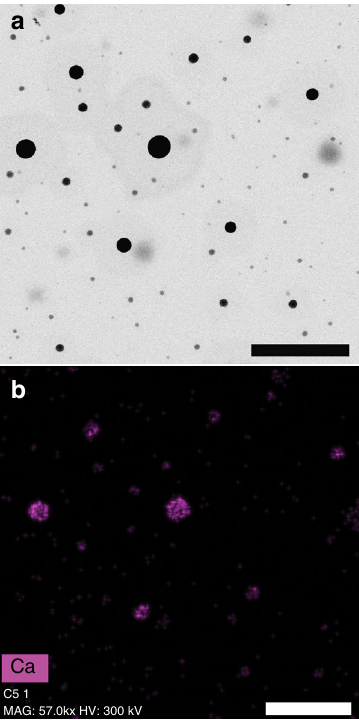
Fig. 4 Compositional analysis of initial calcium oxalate precipitates. a STEM-HAADF image of calcium oxalate precipitates formed in the presence of 10 mM citrate at pH 6.2, showing two types of distinct rounded nanoparticles: less dense nanoparticles, with diffuse limits and well-de fi ned, denser spherical nanoparticles. Scale bar : 200 nm. b Calcium elemental EDS map of the area in a . Scale bar : 300